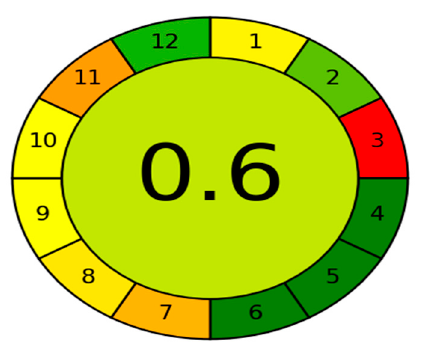
Figure 3. Results of AGREE analysis for the developed HPLC method. For further assessment of the greenness of this method, another greenness metric tool, the RGB additive color model [45], was used. It is based on three primary colors (red, green, and blue), which correlate to the three main characteristics of each analytical method: analytical performance (R), safety/ecological friendliness (G), and productivity/practical effectiveness (B). If an analytical method meets all of the primary criteria to a satisfactory degree, it is classified as white. If it is suitable in terms of only two attributes, the method acquires yellow, magenta, or cyan, and if it has only one attribute and lacks the other two, it acquires red, green, or blue. The evaluation of greenness is objectively quantified by a Color Score (CS) ranging from 0% to 100%, with a CS of 66.6% corresponding to “satisfaction range” and a CS of 33.3% representing “tolerance